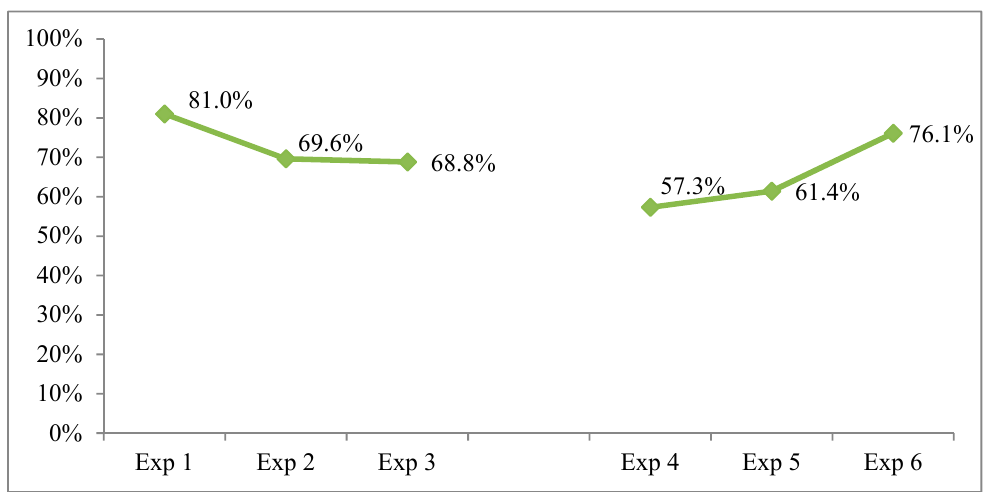
Figure 7. Quizzes average percentage correct by game.